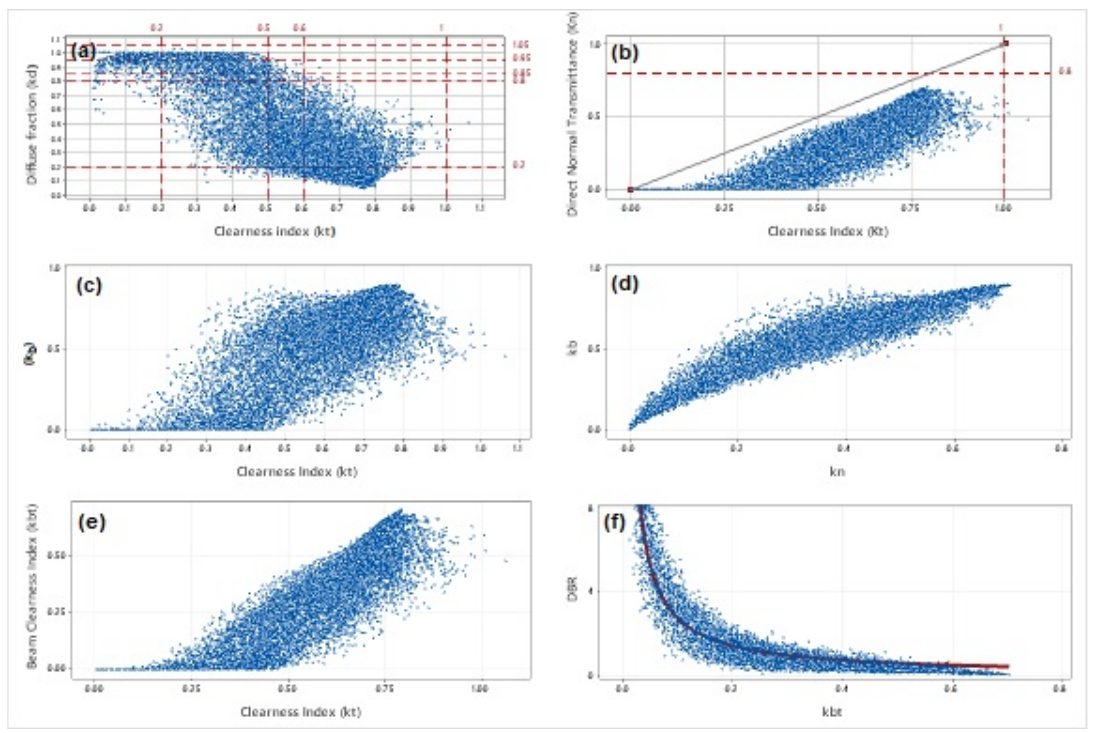
Figure 22. ( a ) Diffuse fraction to global irradiance ( k d ); ( b ) direct normal transmittance ( k n ); ( c ) fraction of direct horizontal radiation to global irradiance ( k b ) as a function of clearness index ( k t ); ( d ) k b vs. k n ; ( e ) k bt vs. k t ; and ( f ) DBR vs. k bt .